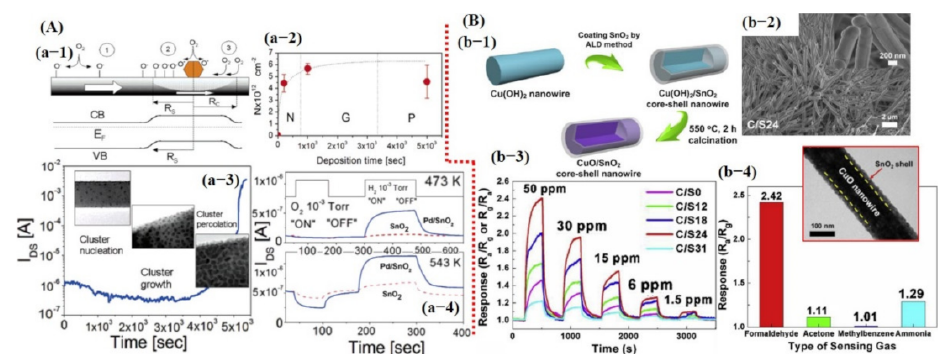
Figure 8. Metal oxide-based gas sensors: ( A ) Pd NPs decorated on the single SnO 2 NW for O 2 and H 2 detection: (a-1) The formation of the depletion region on the nanowire (NW) surface with the Pt NP deposition. As shown in Figure 8 (a-1), the depletion region facilitated in increasing the oxygen adsorbent on the sensing material and consequently improved the sensor performance. (a-2) The Pt NP deposition rate. (b-3) IDS was measured during Au deposition. The onset of the large current increased beyond ≈ 4 × 10 3 s can be attributed to the percolated pathways generated through excessive Au particles. (a-4) The sensing performances of pure SnO 2 and Pd–SnO 2 NW to O 2 and H 2 . Reproduced with permission from [109], copyright 2005 ACS. ( B ) Sensing performance of CuO@SnO 2 core–shell structure for formaldehyde detection. (b-1) Schematic diagram of the fabrication process. (b-2) SEM image of core–shell NW structure. (b-3) Sensor response with different shell thickness; SnO 2 with 24 nm thick shell revealed maximum response. (b-4) Selectivity graph. The inset revealed the TEM image of the core–shell NW structure. Reproduced with permission from [111], copyright 2019